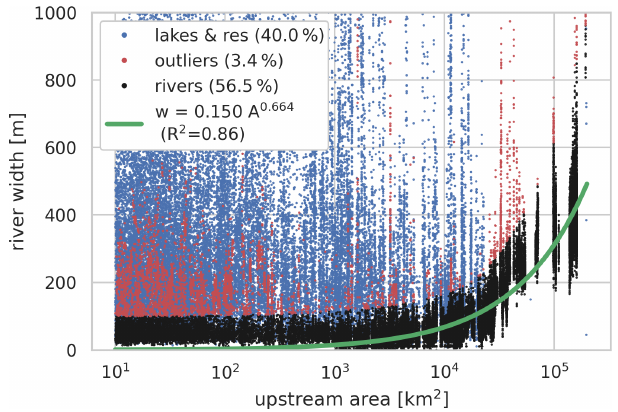
Figure B1. Fitted relationship between the river width and upstream area for the Rhine